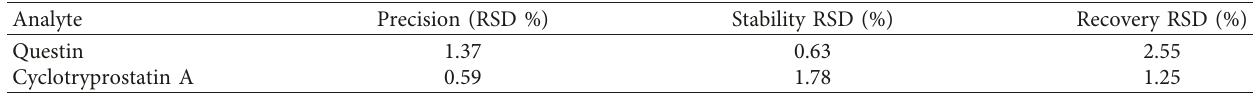
Table 4: Analytical results of precision, stability, and recovery tests.